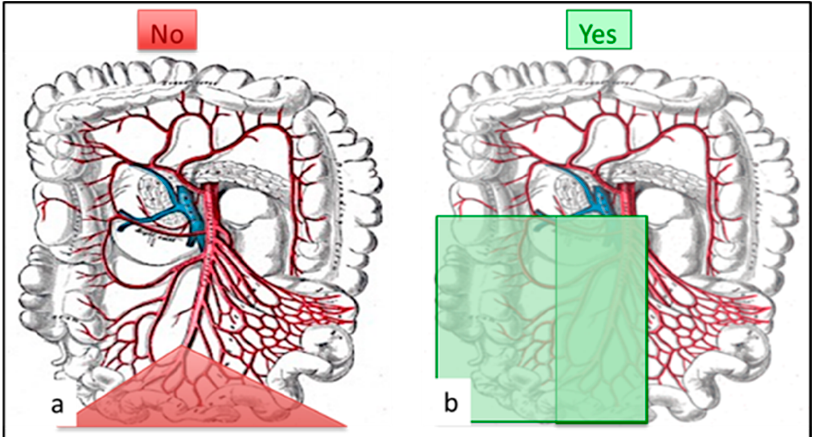
Figure 3. Surgical pattern: ( a ) no more ‘pizza pie’ approach: large intestinal resection with inappropriate lymphadenectomy. ( b ) Appropriate lymphadenectomy should remove at least 8 (better 12) lymph nodes with small intestinal resection. The ileocecal valve and right colon might require resection mainly for LN-stage III patients.